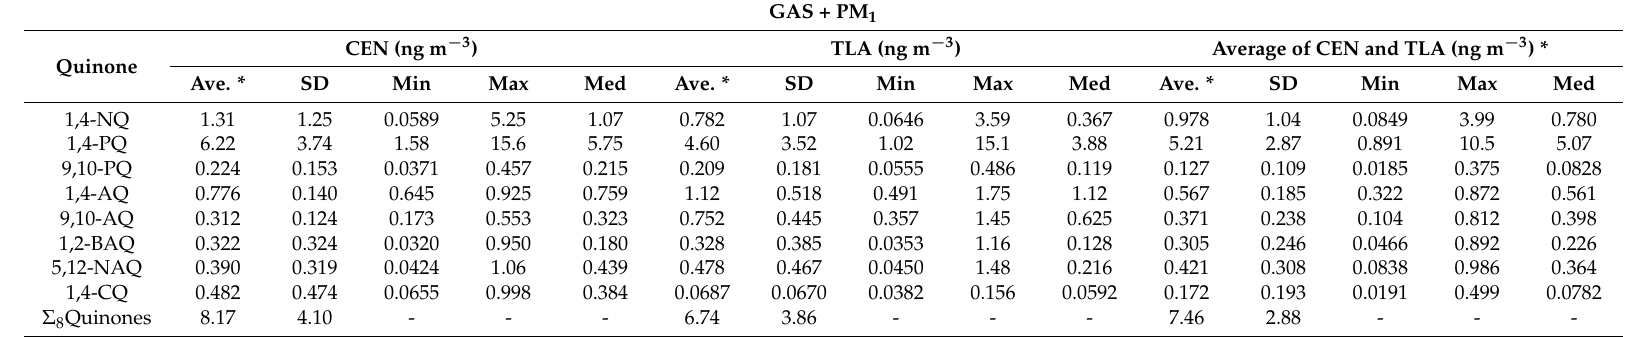
Table 7. Total ambient levels of quinones in the gas and PM 1 phases in the GMA.